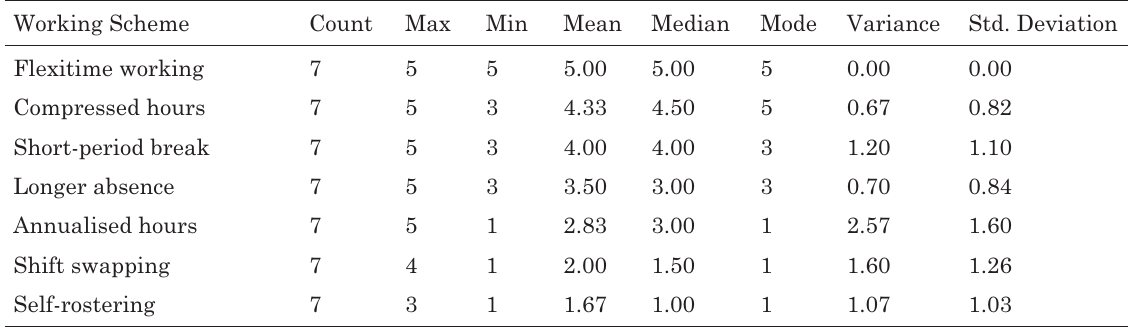
Table 3. Adoptability degree of fl exible working schemes